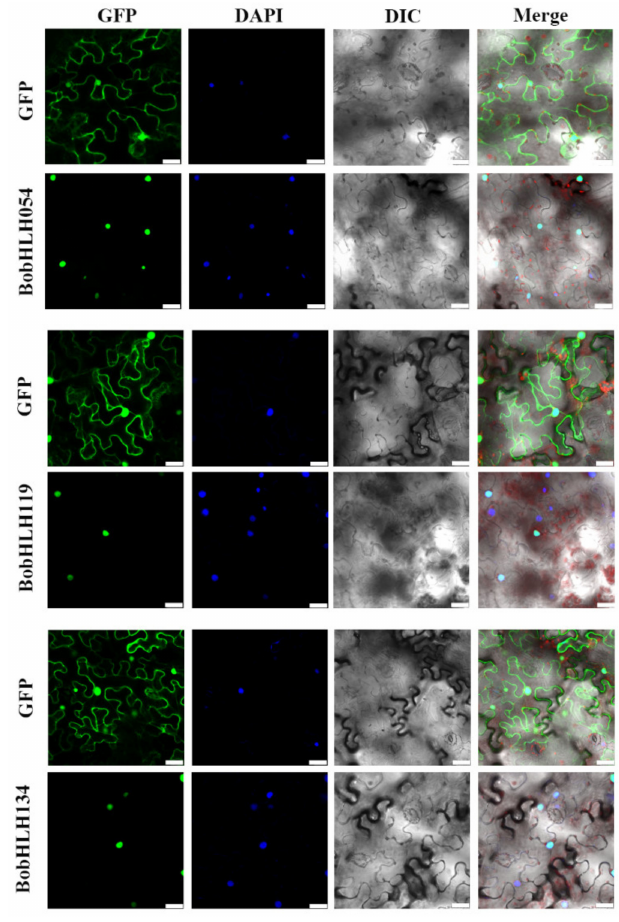
Figure 8. Subcellular localization analysis of BobHLH054, BobHLH119, and BobHLH134 in tobacco leaf epidermal cell. GFP stands for green fluorescence field, DAPI for DAPI field (nuclear staining), DIC for open field, Merge for superposition field. Excitation wavelength: GFP field: 488 nm, DAPI field: 358 nm, note that green fluorescence is the same as chloroplast spontaneous fluorescence excitation light and the wavelength of collected light is di ff erent. Bar = 25 µ